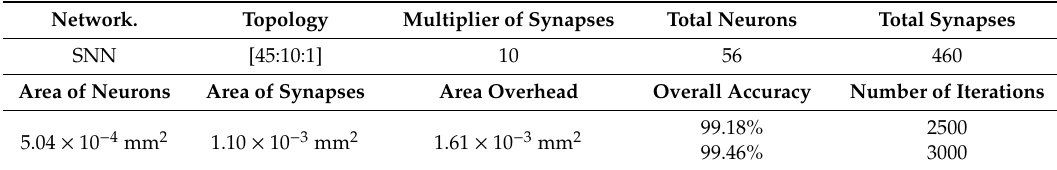
Table 6. SNN setting and result (mean samples).